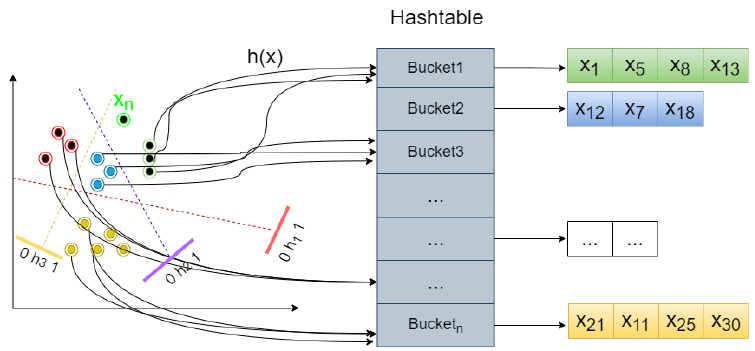
Figure 8. LSH builds index.